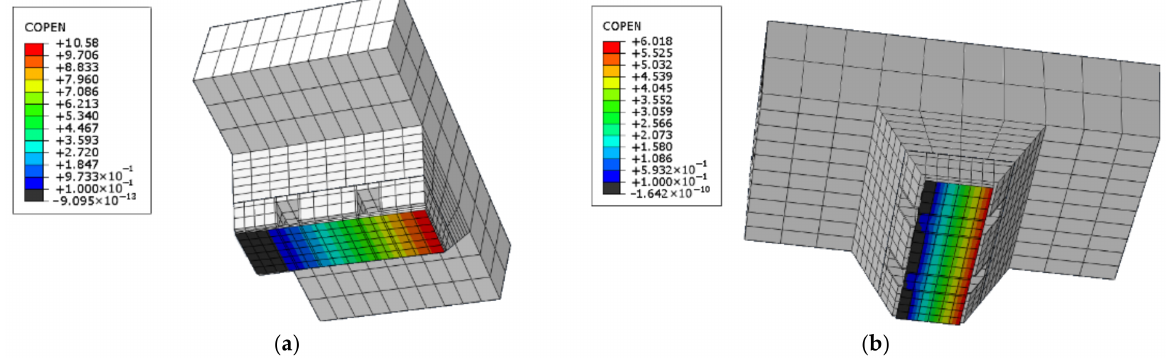
Figure 26. Space between the contact surface of the T-segment and LZ block. ( a ) Contact surface under rZ error; ( b ) Contact surface under rT